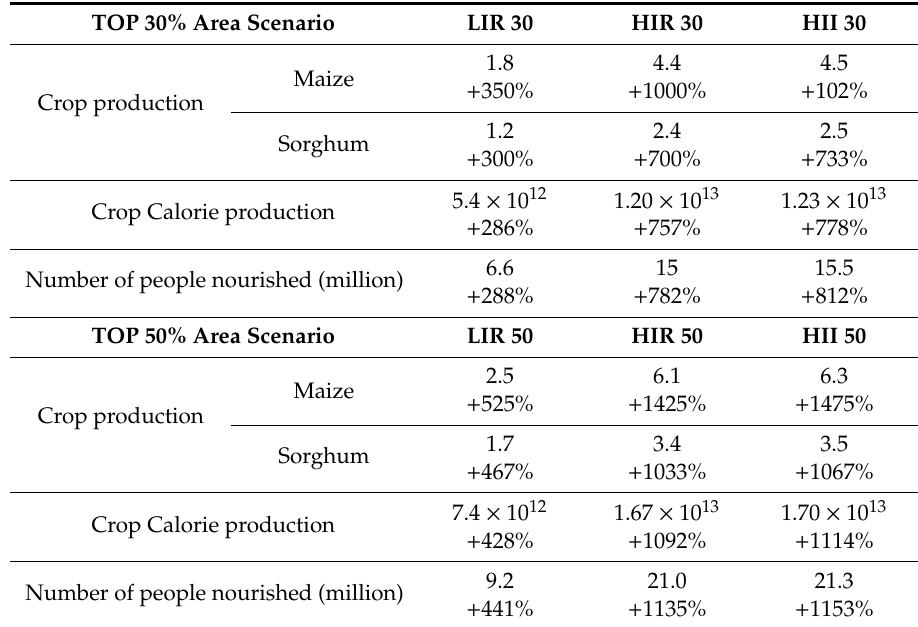
Table 1. Crop (Mt year − 1 ) and calorie (kcal year − 1 ) production and number of people that can be nourished in the land use scenarios, with absolute number and relative percentage di ff erence with reference to the reference yield /